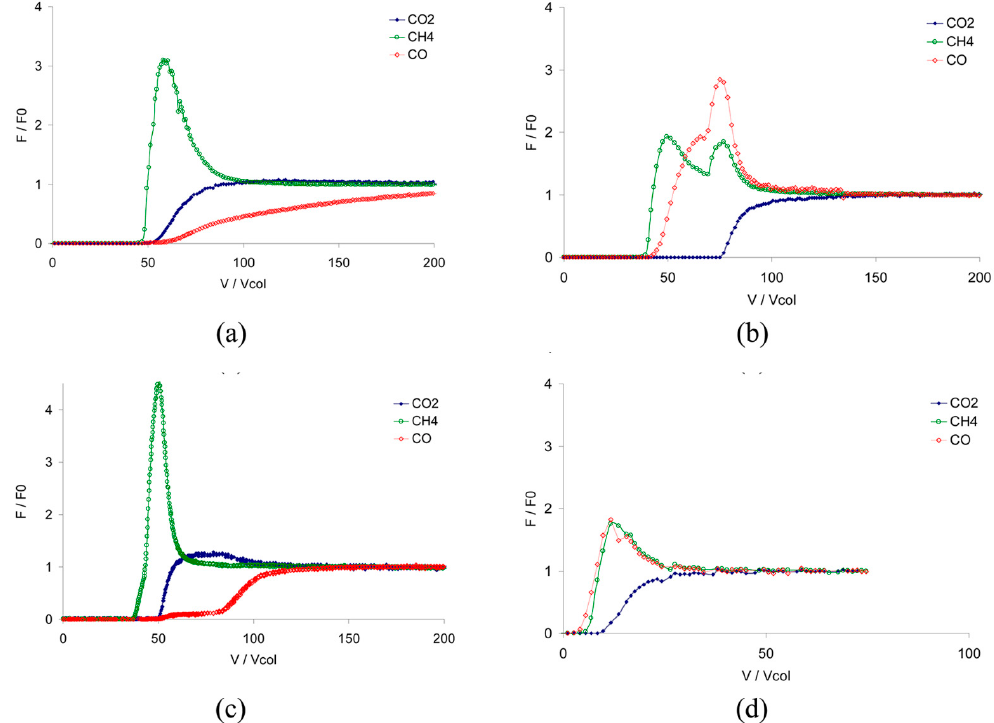
Figure 28. Breakthrough curves of the CO 2 /CH 4 /CO (70/15/15) mixture on ( a ) CPO-27-Co, ( b ) CPO-27-Zn, ( c ) CPO-27-Ni, and ( d ) STA-12-Ni at 303 K and 5 bar. Reprinted with permission from reference. [71]. Copyright 2011, Elsevier Inc.